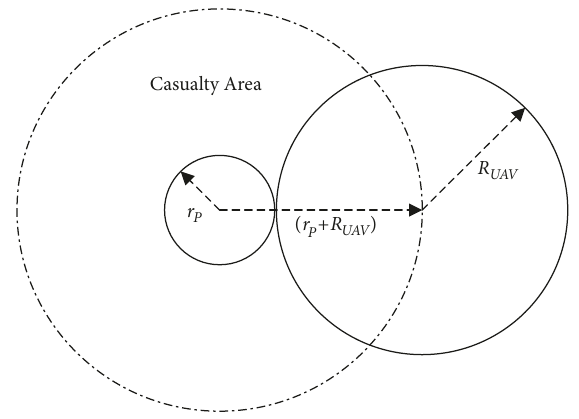
Figure 2: Vertical impact analysis.